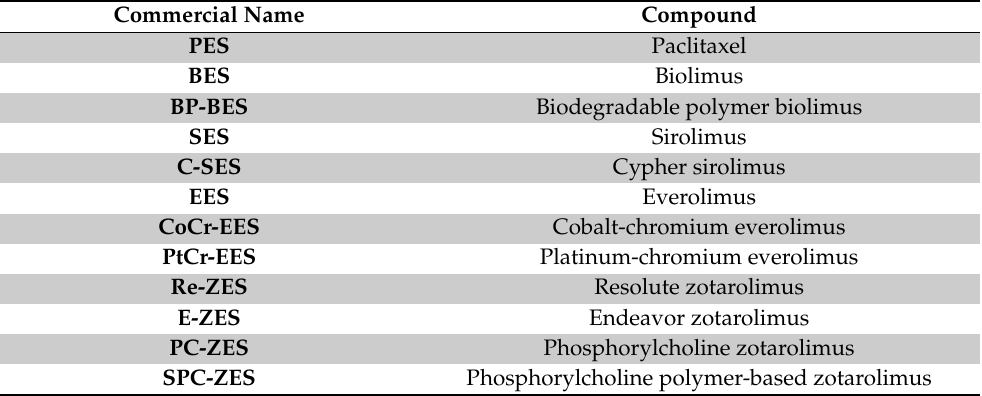
Table 3. Summary of the polymers currently used in stents and